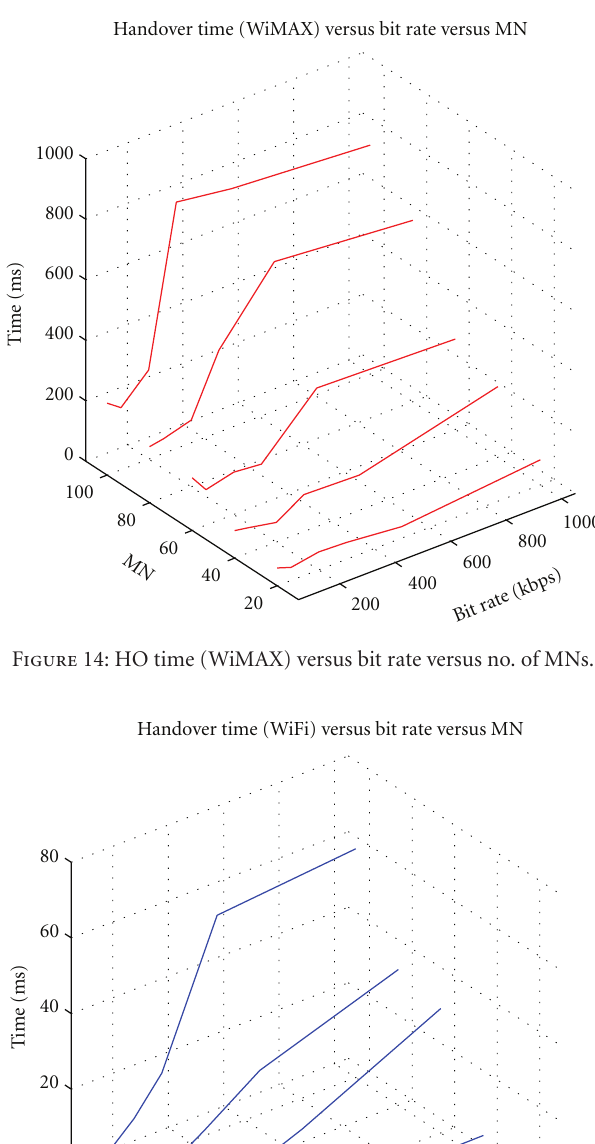
to bad quality. For video, only non-interactive applications would be allowed, because bu ff ering and retransmission of lost packets are possible. If tra ffi c flow has an increased bit rate, see Figure 13, video support would degrade to unacceptable